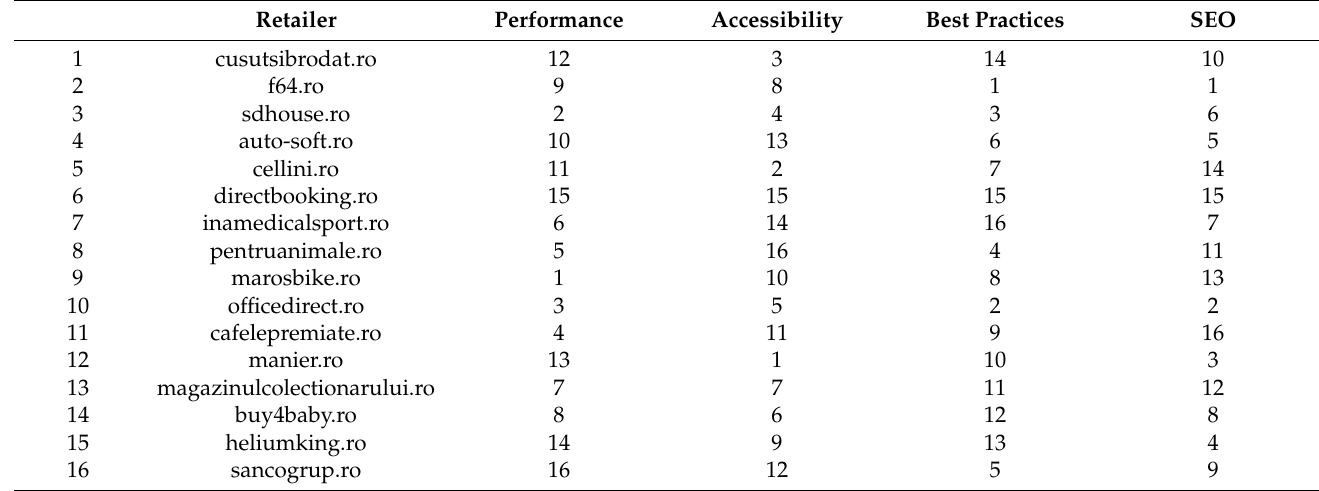
Table 7. The 2nd place matrix for Performance, Accessibility, Best Practices, and SEO indicators.